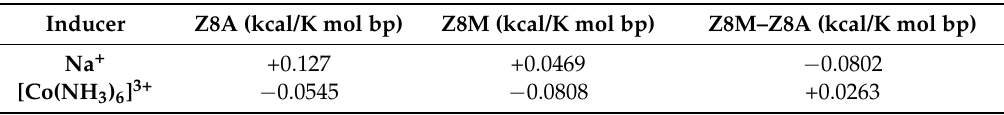
Table 2. Increasing the concentration of Na + from 115 mM to 2.0 M results in an increase in the heat capacities of both Z8A and Z8M by 127 and 47 cal/K mol bp, respectively. On the other hand,